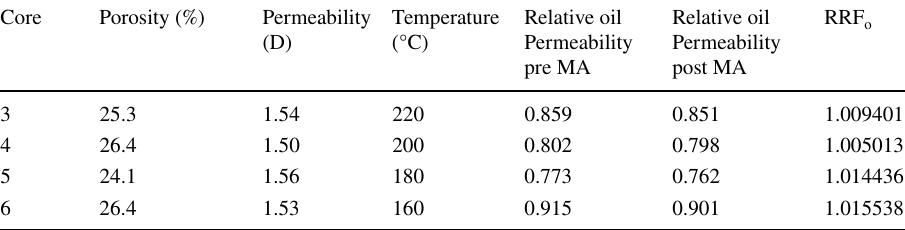
Table 2 RRF o comparison pre and post MA injection with various temperature drops